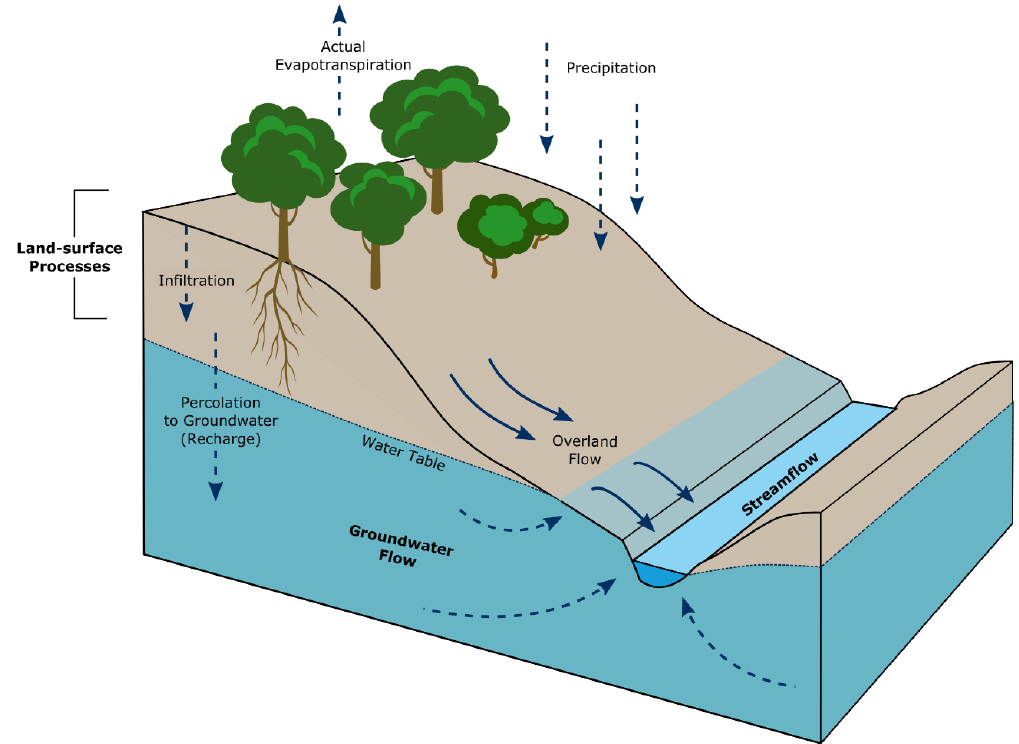
Figure 5. Porous media, terrestrial hydrologic cycle schematic. The watershed water budget, or land-surface processes balance, and the groundwater water budget combine to provide a full terrestrial hydrologic cycle representation. Precipita- tion is the ultimate source of natural watershed water and groundwater. Actual evapotranspiration (AET) returns water vapor to the atmosphere. Recharge is water that flows downwards across the water table from the vadose zone. Runoff is composed mainly of overland flow and is the water that goes directly to generate stream flow without crossing the water table of an aquifer.